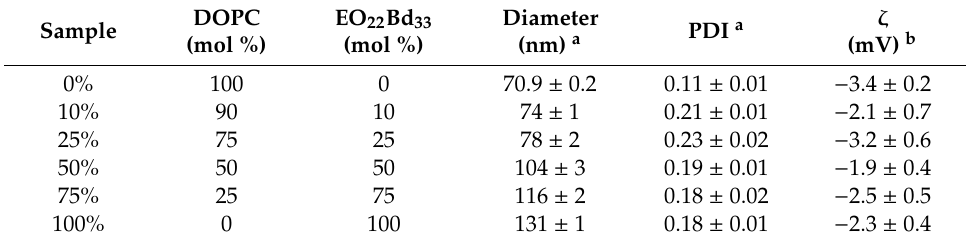
Table 1. Characterization of hybrid lipid / polymer vesicles.